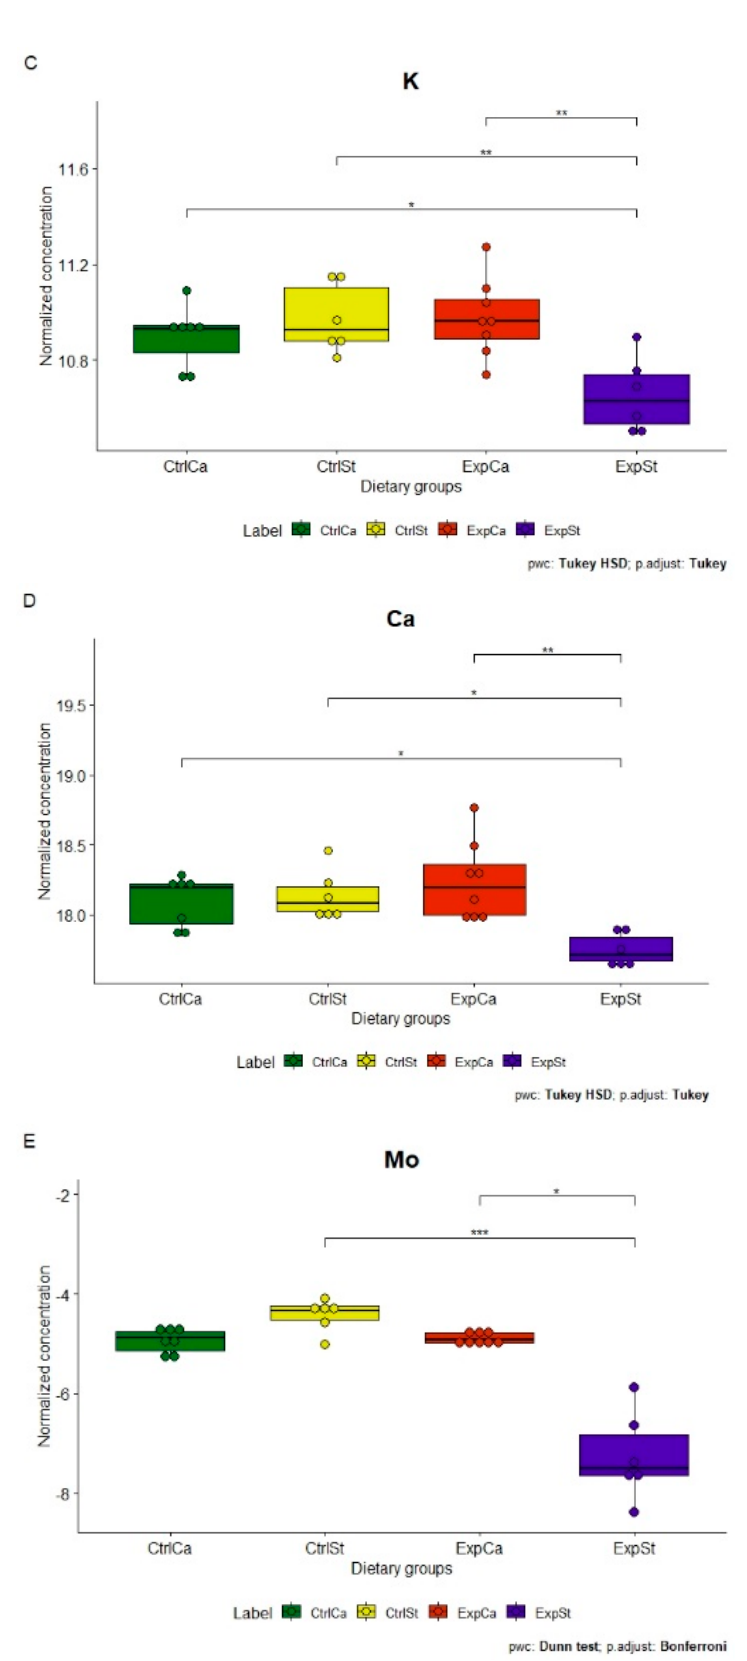
Figure 2. Analysis of concentrations of elements in four experimental groups: ExpSt—experimental standard diet with LNCaP (violet boxplot), CtrlSt—control standard diet without LNCaP (yellow boxplot); ExpZn—Zn supplementation diet with LNCaP (green boxplot); CtrlZn—Zn supplementation diet without LNCaP (red boxplot); p -value: <0.0001 ****, 0.0001–0.001 ***, 0.001–0.01 **, 0.01–0.05 *.